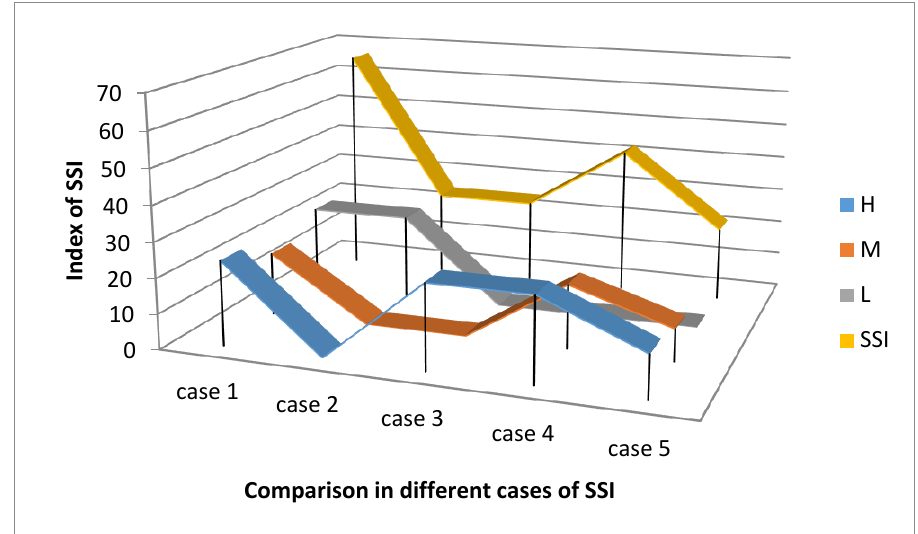
Figure 7. The Comparison in different cases of SSI.